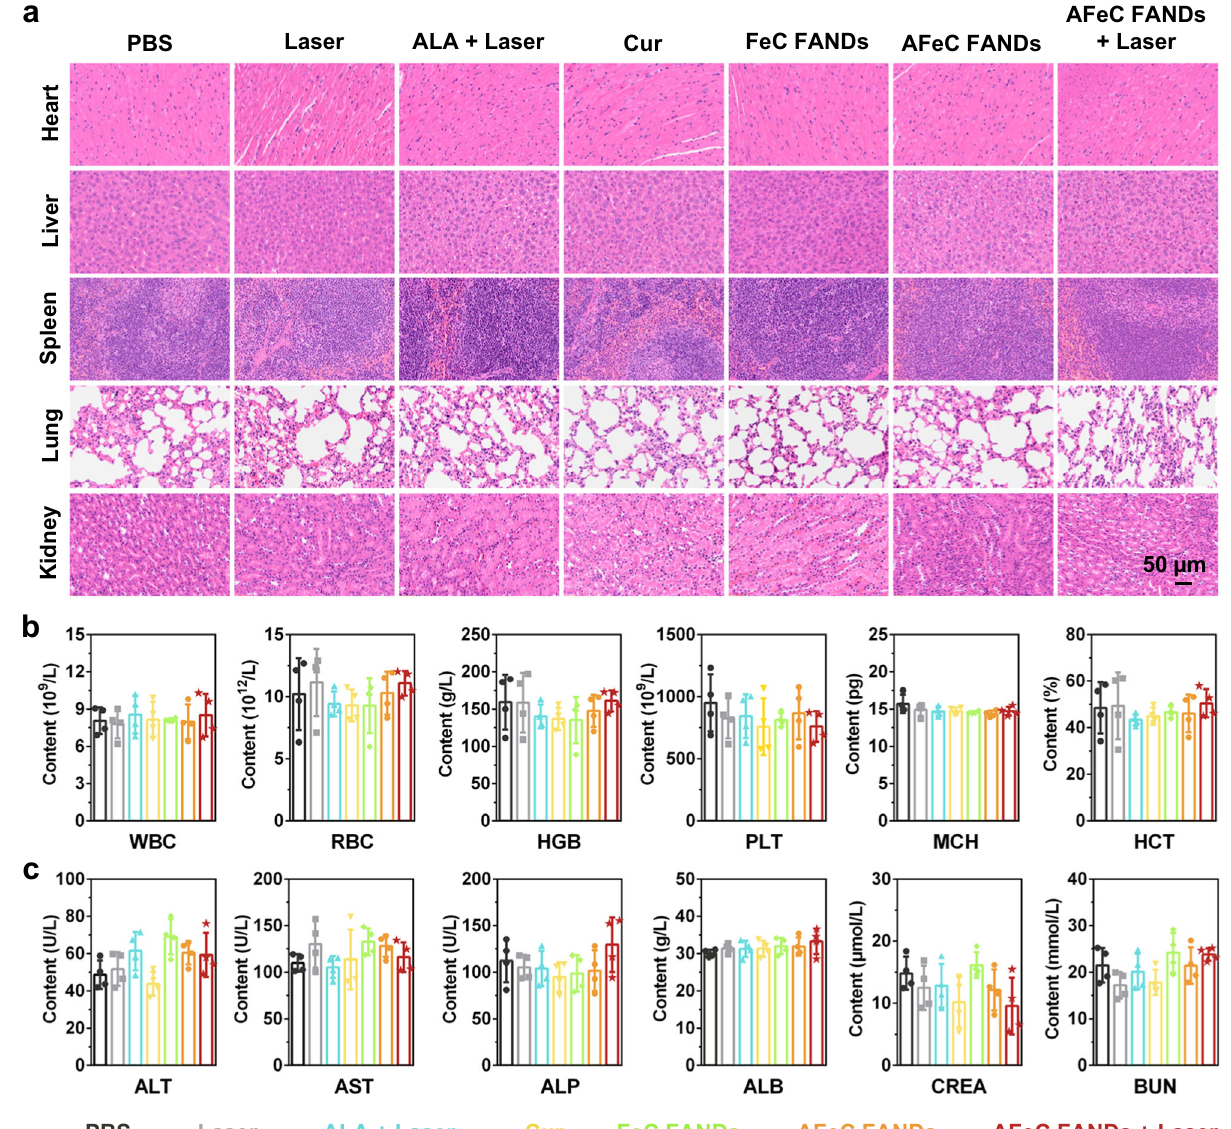
Fig. 7 | In vivo safety assessments of the AFeC FANDs. a Hematoxylin and eosin (H&E) staining of major organs collected from mice after different treatments. b The blood parameter and c serum biochemistry analysis of mice in various